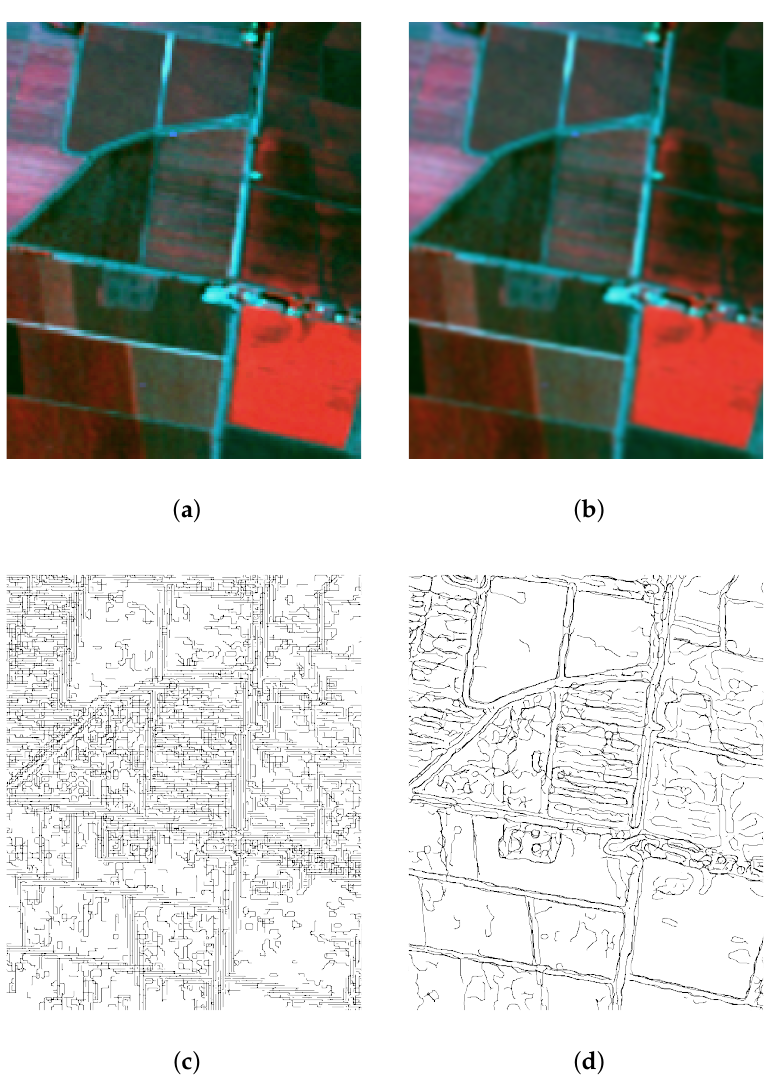
Figure 1. Comparison between original and rolling guidance filter (RGF) filtered images and their edges. ( a ) Original multispectral (MS) image; ( b ) MS filtered image using RGF ( t = 4, σ s = 3 and σ r = 0.2); ( c ) MS edges obtained from their gray scale version using the Canny filter; and ( d ) Edges of the filtered MS using RGF, obtained from the gray scale version using the Canny